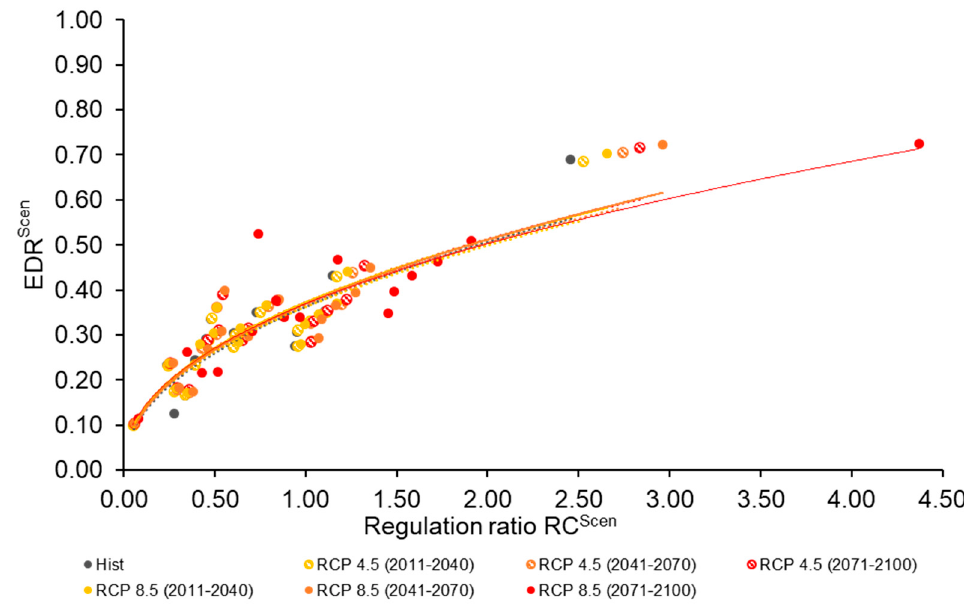
Figure 5. Relationship between the regulation coefficient RC and annual EDR for the various climate scenarios.